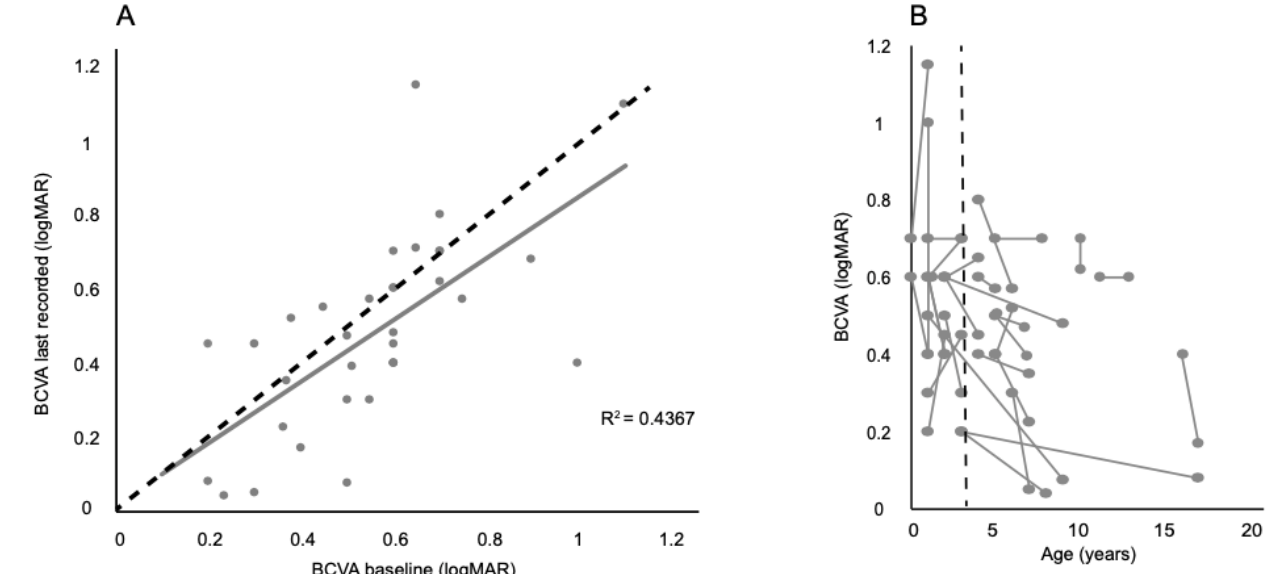
Figure 1. Best corrected visual acuity (BCVA) changes in albinism patients. ( A ) Correlation between the change in BCVA at baseline and most recent follow up. The black dashed line represents a ‘no change’ scenario, while the grey correlation line illustrates the subtle change seen in patients. ( B ) Demonstrates the change in BCVA of each paediatric patient at baseline and most recent vision as a function of age. The black dashed line represents the point at which more accurate visual acuity testing can be achieved in children 3 years old and